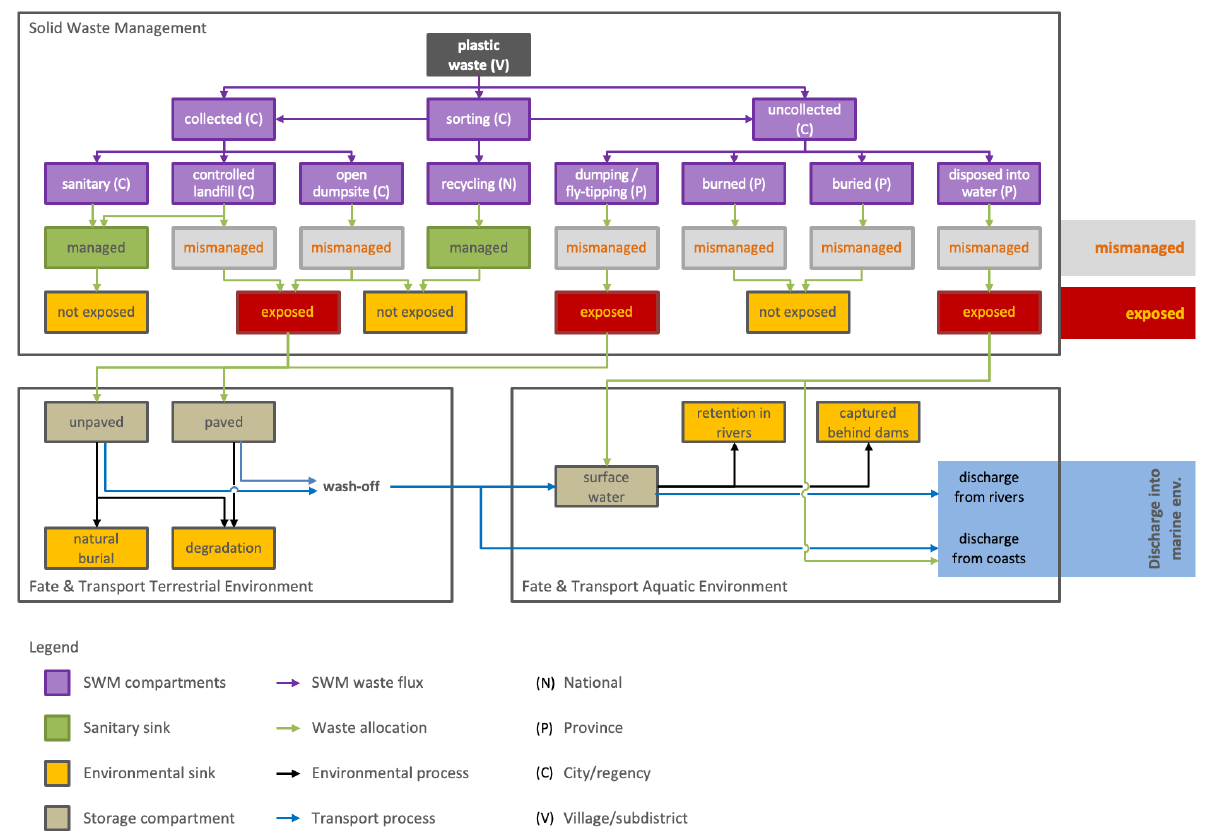
Figure 1. Conceptual framework of the plastic fluxes and processes modeled in the study.